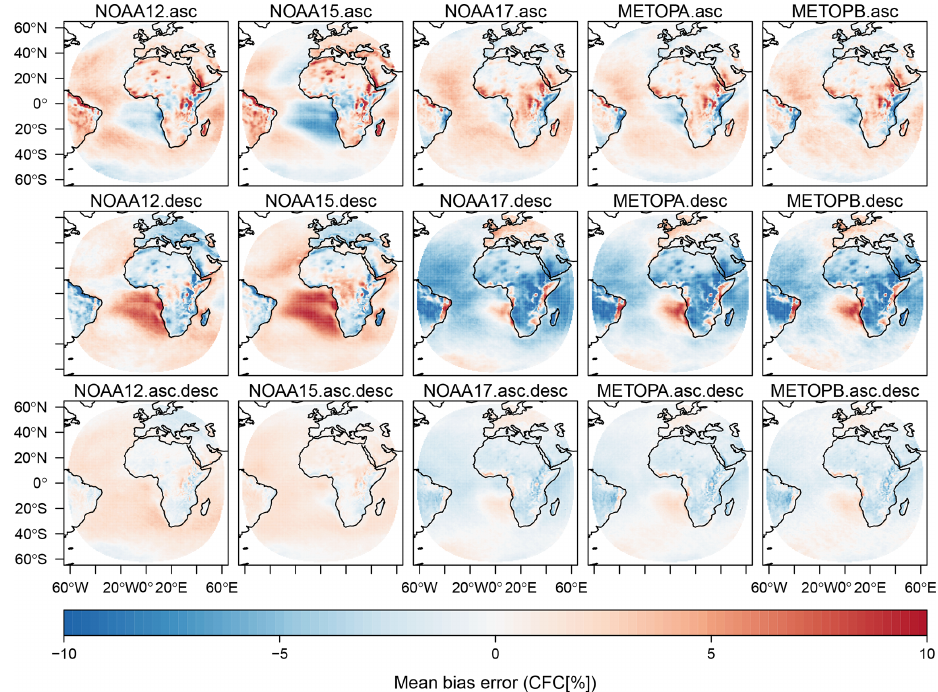
Figure 6. Mean bias error of CFC caused by discrete sampling of CFC diurnal cycle presented for each morning (AM) NOAA satellite and each node (asc – ascending, desc – descending, and asc.desc – scending and descending